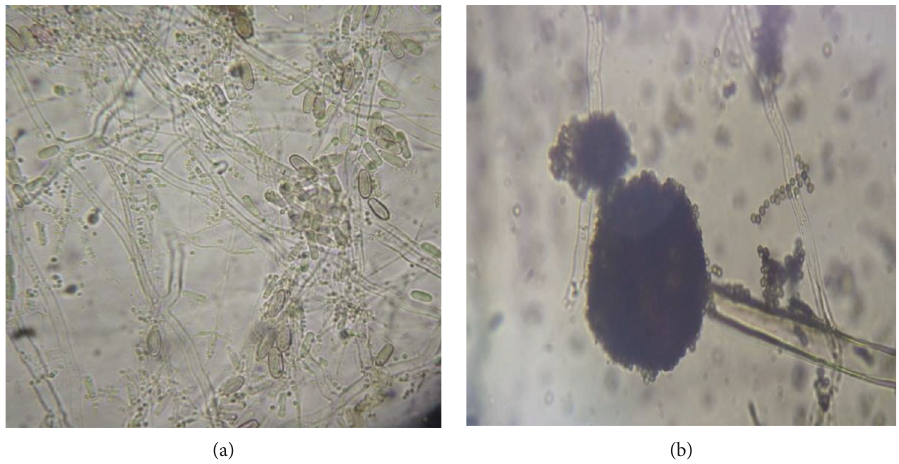
Figure 3: Microscopic views of (a) Fusarium oxysporum ( × 400) and (b) Aspergillus niger ( × 400).